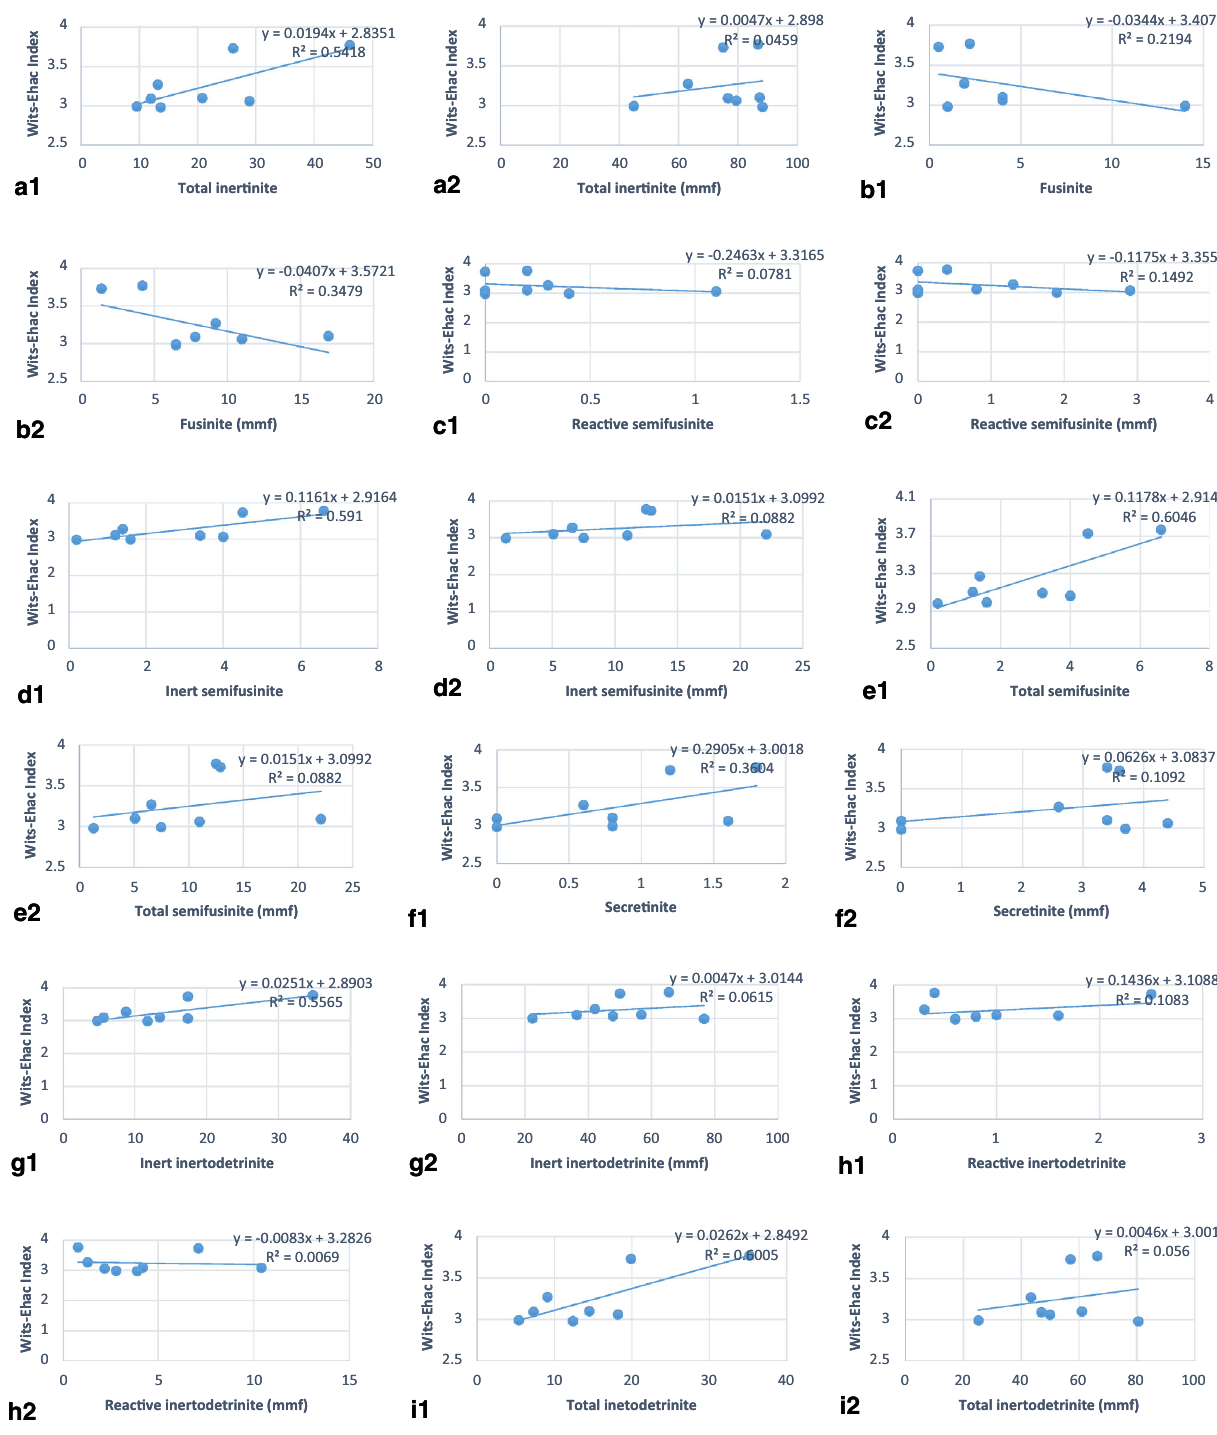
Fig. 9 Influence of total inertinite and its group on spontaneous combustion liability of